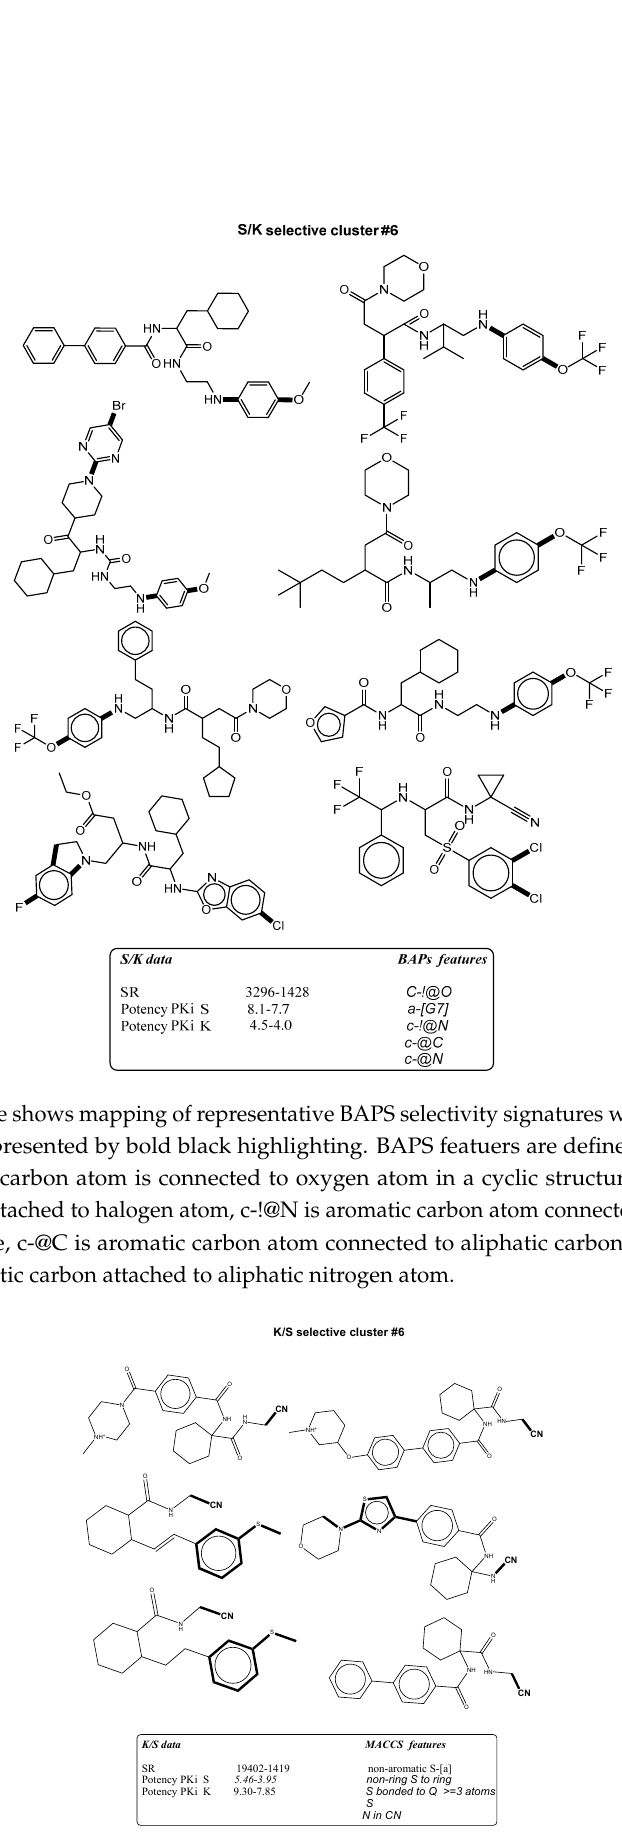
Figure 4. The figure shows mapping of representative MACCS selectivity signatures with high occurrence to K/S selectives presented by bold black highlighting.